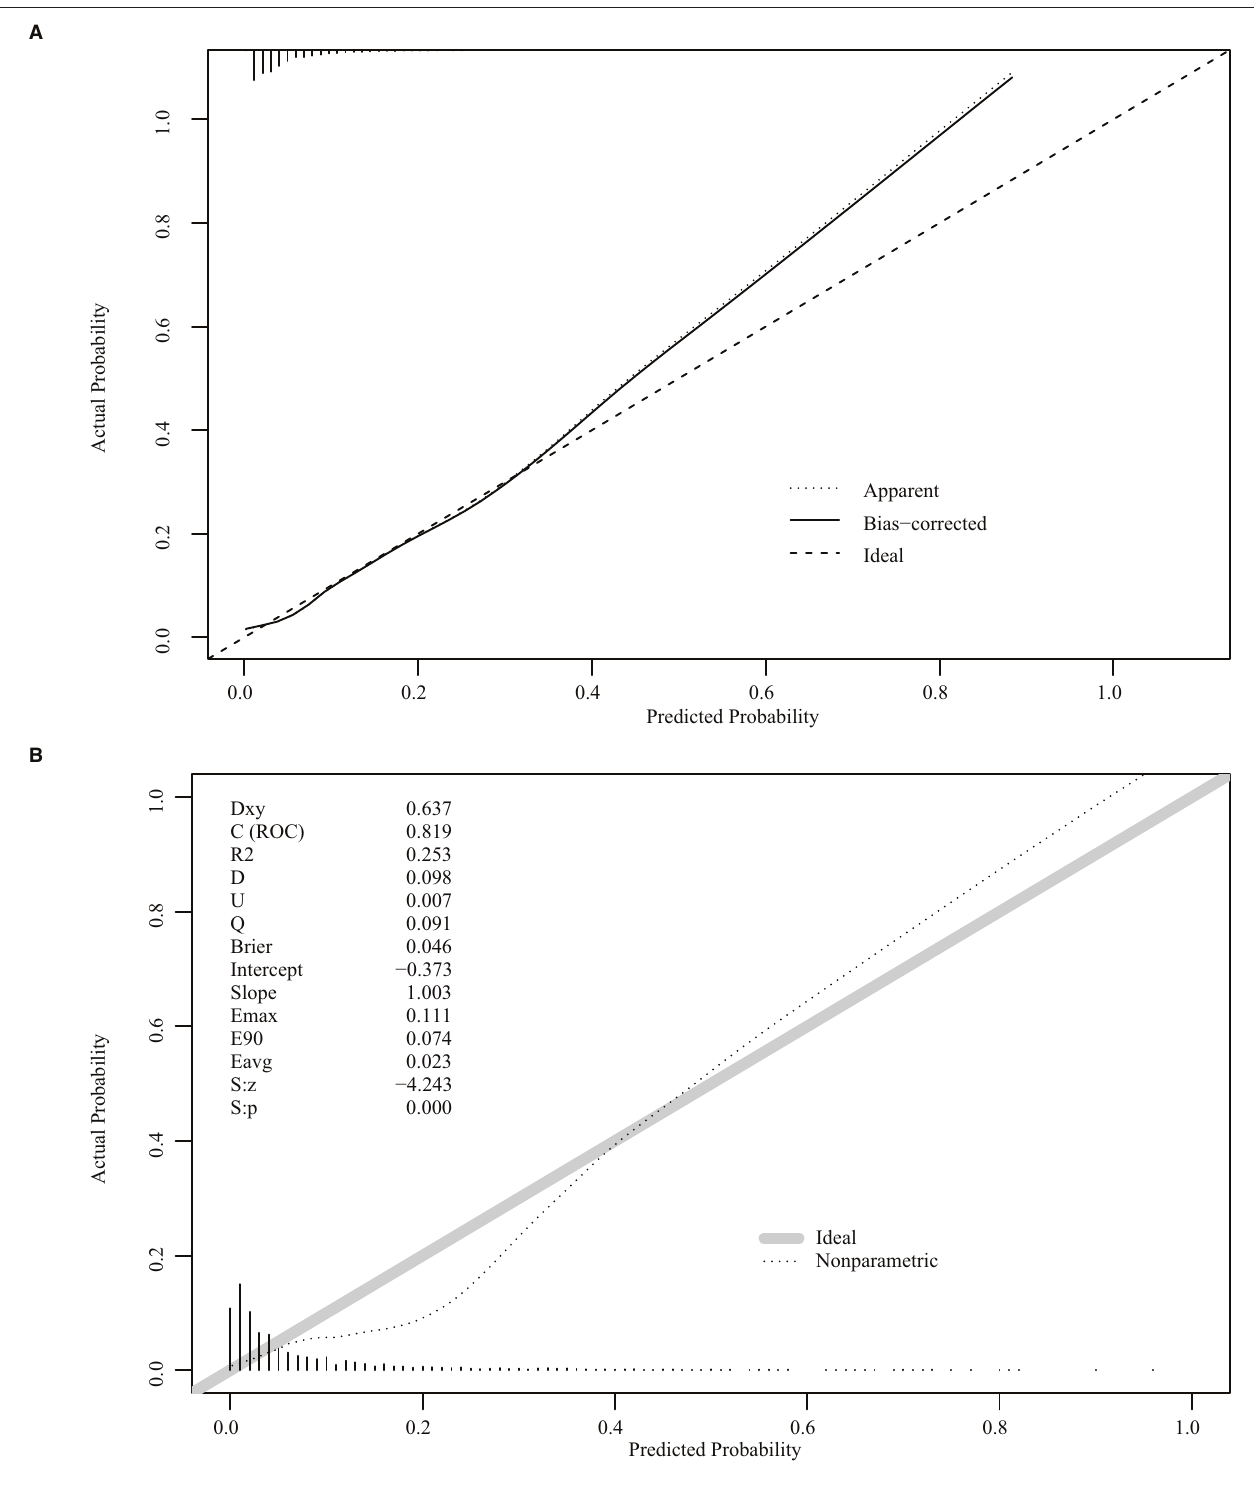
FIGURE 4 | Internal and external validation plots of the nomogram calibration curves. (A) Internal validation; (B) External validation.